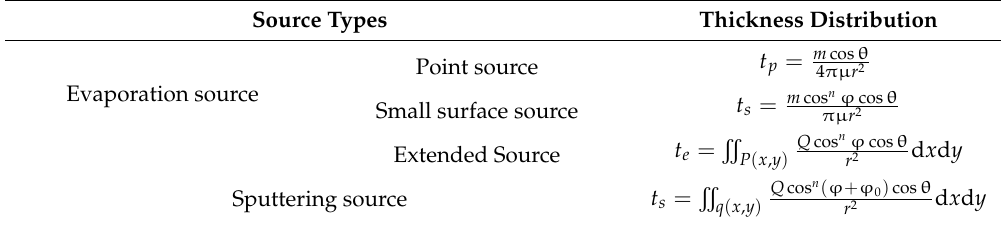
Figure 5. ( a ) Racetrack shape in rectangular sputtering target; ( b ) racetrack in circle shaped target. Thin film thickness with different types of sources is summarized in Table 2. Table 2. Thin film thickness distributions for different types of sources.